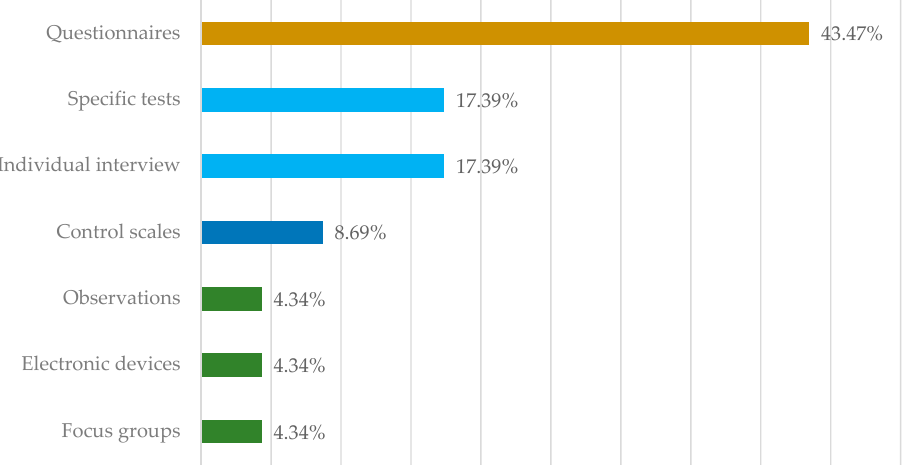
Figure 2. Evaluation instruments used in the different publications .